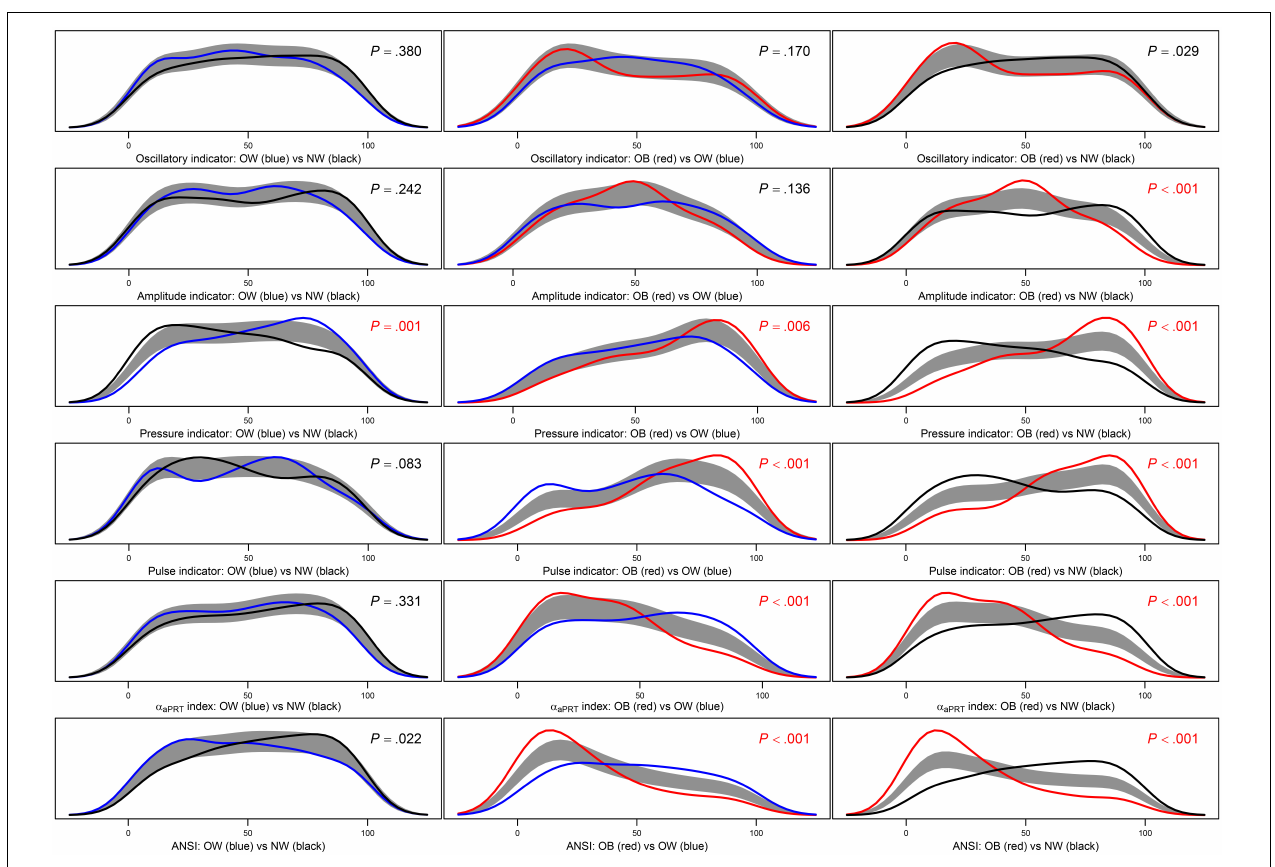
FIGURE 5 | Panel plot of estimated density curves and non-parametric 95%-confidence regions for the pairwise equality of the distributions of the four ANS indicators, the α aPRT index, and ANSI within the BMI groups. Density estimates are obtained through the kernel density method by Bowman and Azzalini (1997) in order to have smoothed empirical density curves. In the above panels, the black curve refers to the normoweight group, the blue curve to the overweight group, and the red curve to the obese group. The gray region is a reference band for the equality test of the curves in each pairwise comparison, i.e., H 0 : f g ( y ) = f g (cid:48) ( y ) , for all y , against: H 1 : f g ( y ) (cid:54)= f g (cid:48) ( y ) , for at least one y , where f g ( y ) and f g (cid:48) ( y ) are population density functions of the synthetic indicator Y within the BMI groups g and g (cid:48) , respectively, with g (cid:54)= g (cid:48) = NW, OW, and OB. P -values of the Bowman and Azzalini (BA) test are reported in each panel. A Bonferroni correction is applied to the nominal significance level α = 0 . 05 to preserve the significance level of the overall null hypothesis H 0 : f NW ( y ) = f OW ( y ) = f OB ( y ) , for all y . Because there are three distinct pairwise comparisons for each indicator Y , the significance level applied to each BA test is: α ∗ = 0 . 05 3 = 0 . 017. P -values resulted as lower or equal to α ∗ are written in